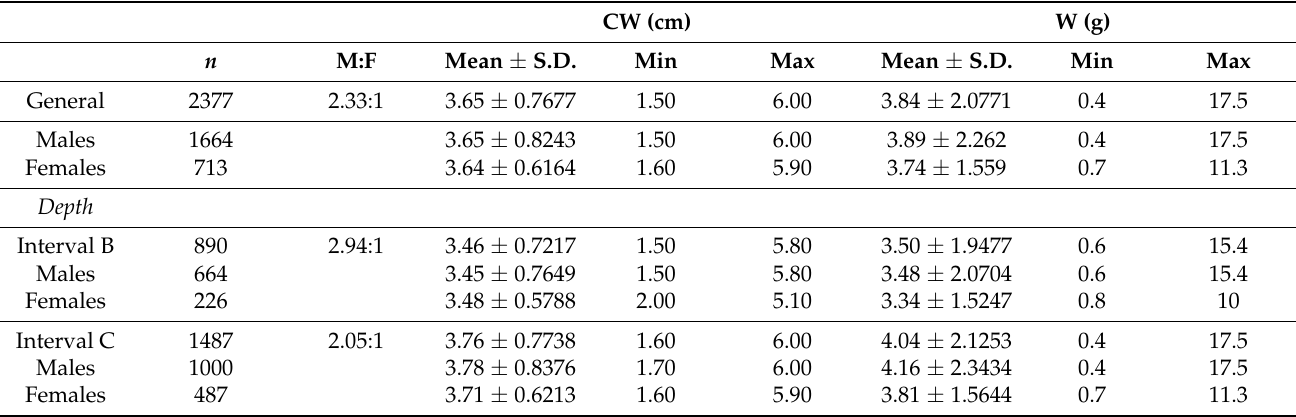
Table 1. Total number of crabs ( n ), sex ratio (M:F), Mean value and standard deviation (Mean ± S.D.), Minimum value (Min), Maximum value (Max) and number of crabs for carapace width (CW) and weight (W) for total crabs (General), by sex, trawl depth intervals (Interval B and C) for Achelous spinicarpus